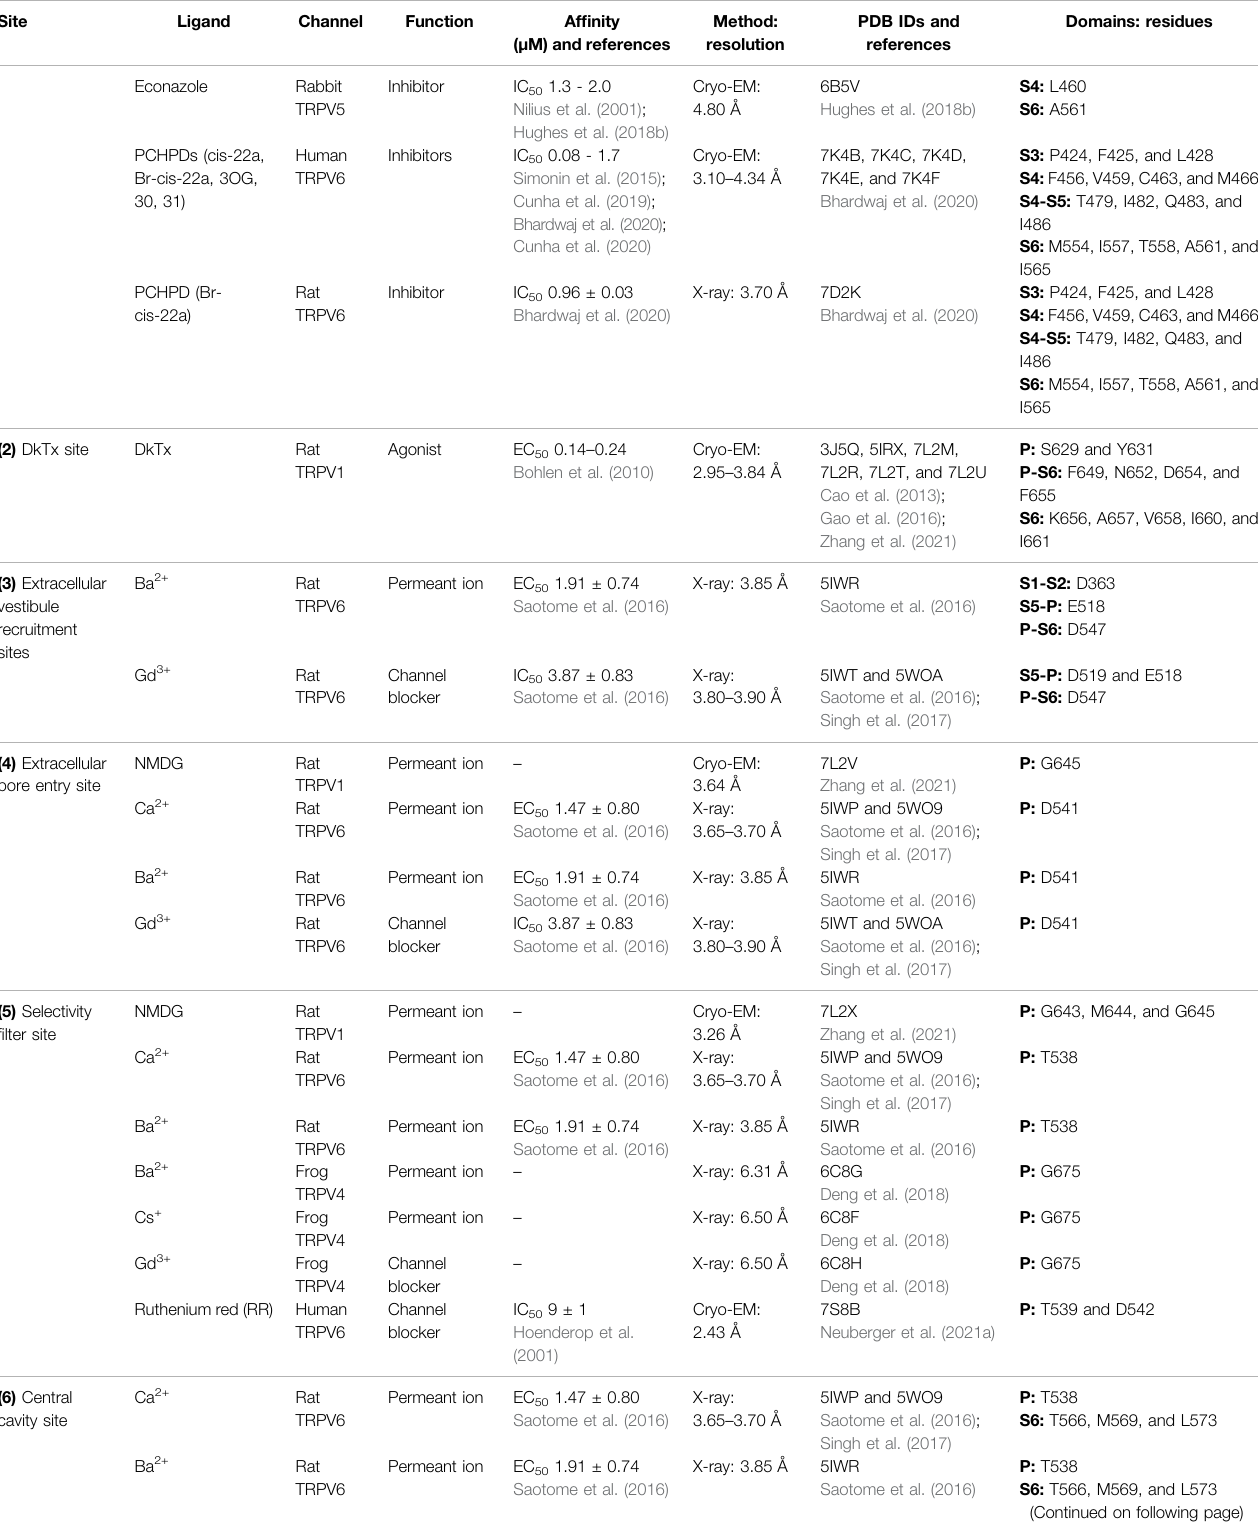
TABLE 1 | ( Continued ) Ligand binding sites in TRPV